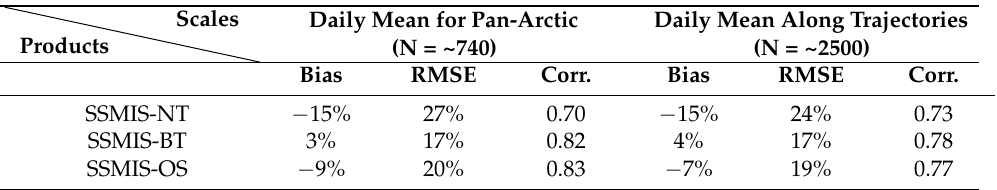
Table 2. The biases, RMSEs, and correlation coefficients (Corr.) of the three SSMIS-based products on two different scales, with different sample numbers.